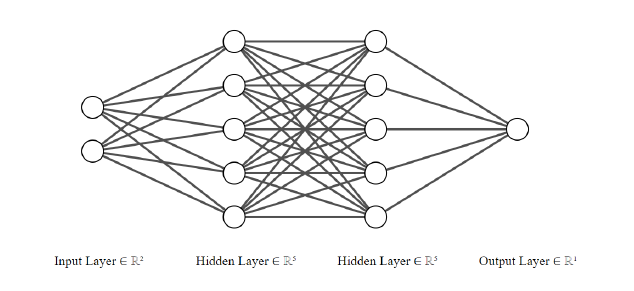
Figure 1. Deep neural network: A fully connected multi-layer neural network that consists of one input layer, two hidden layers and one output layer. Here, R n shows an n-dimensional real number